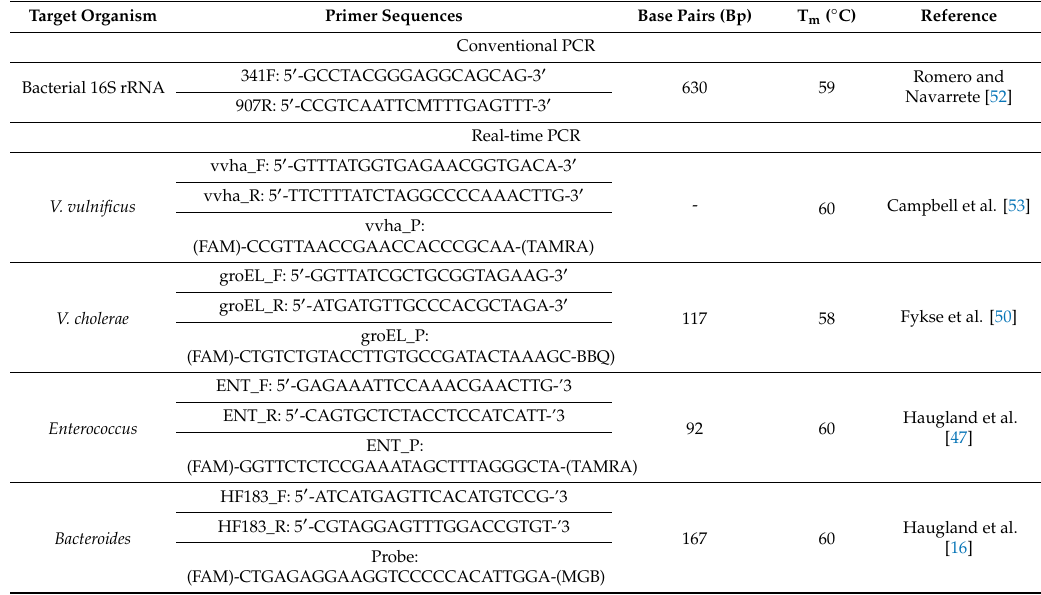
Table1. Oligonucleotideprimersusedformultiplexpolymerasechainreaction(PCR)andreal-timePCR. Target